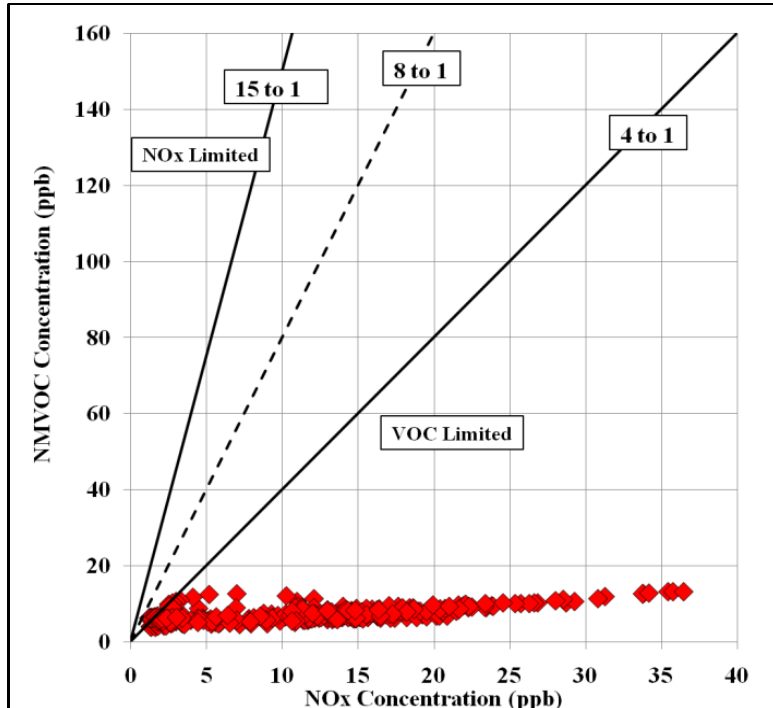
Figure 6. Scatter plots of NMVOC to NOx ratio over Delhi. Table 2. Sector-wise percentage reduction in emissions and the corresponding reduction in ambient concentrations.